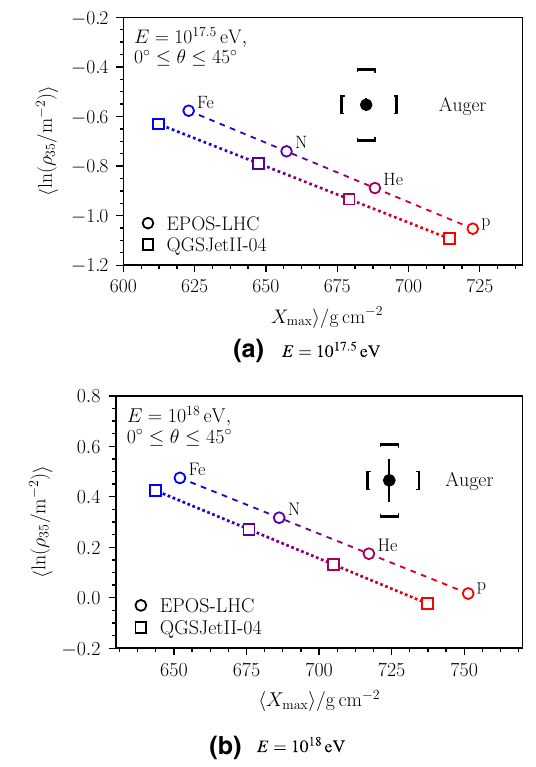
Fig. 12 Mean logarithmic muon density (cid:14) ln ρ 35 (cid:15) as a function of the mean depth of shower maximum (cid:14) X max (cid:15) for simulations with primary energies of 10 17 . 5 eV ( a ) and 10 18 eV ( b ) compared to Auger Observa- tory measurements with the FD